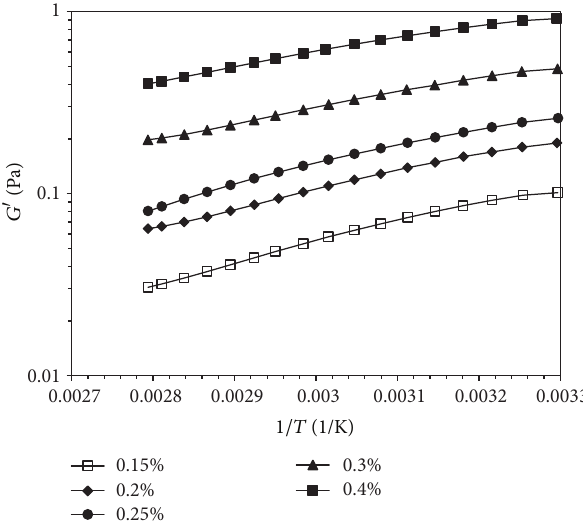
Figure 13: Effect of copolymer concentration on storage modulus of SP solution at different